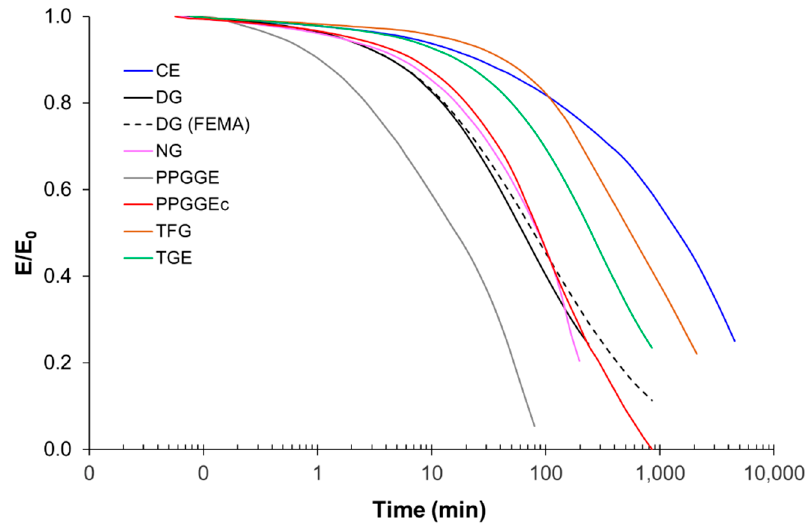
Figure 8. Stress relaxation of formulations containing different epoxides.